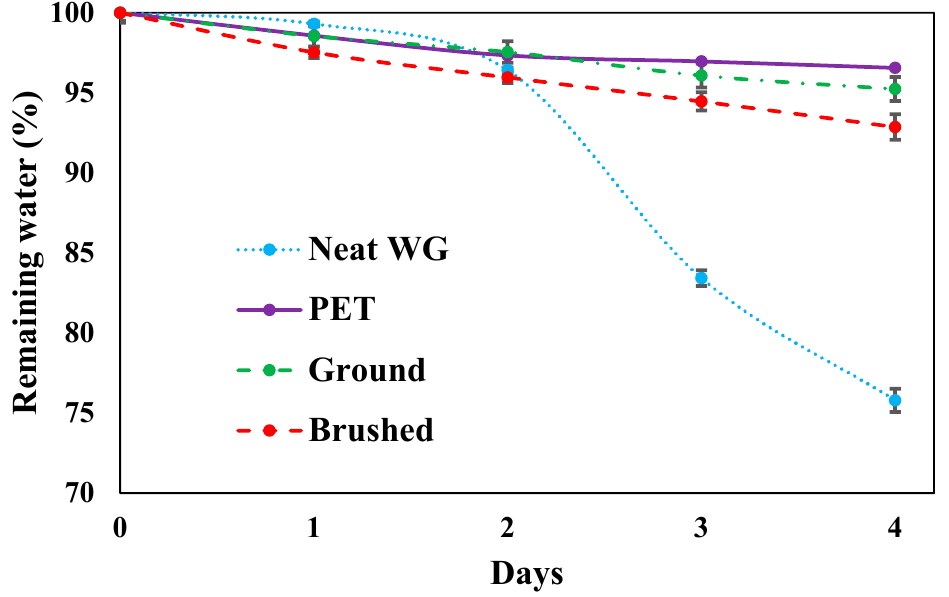
Figure 10. Water content inside the cup as a function of time.